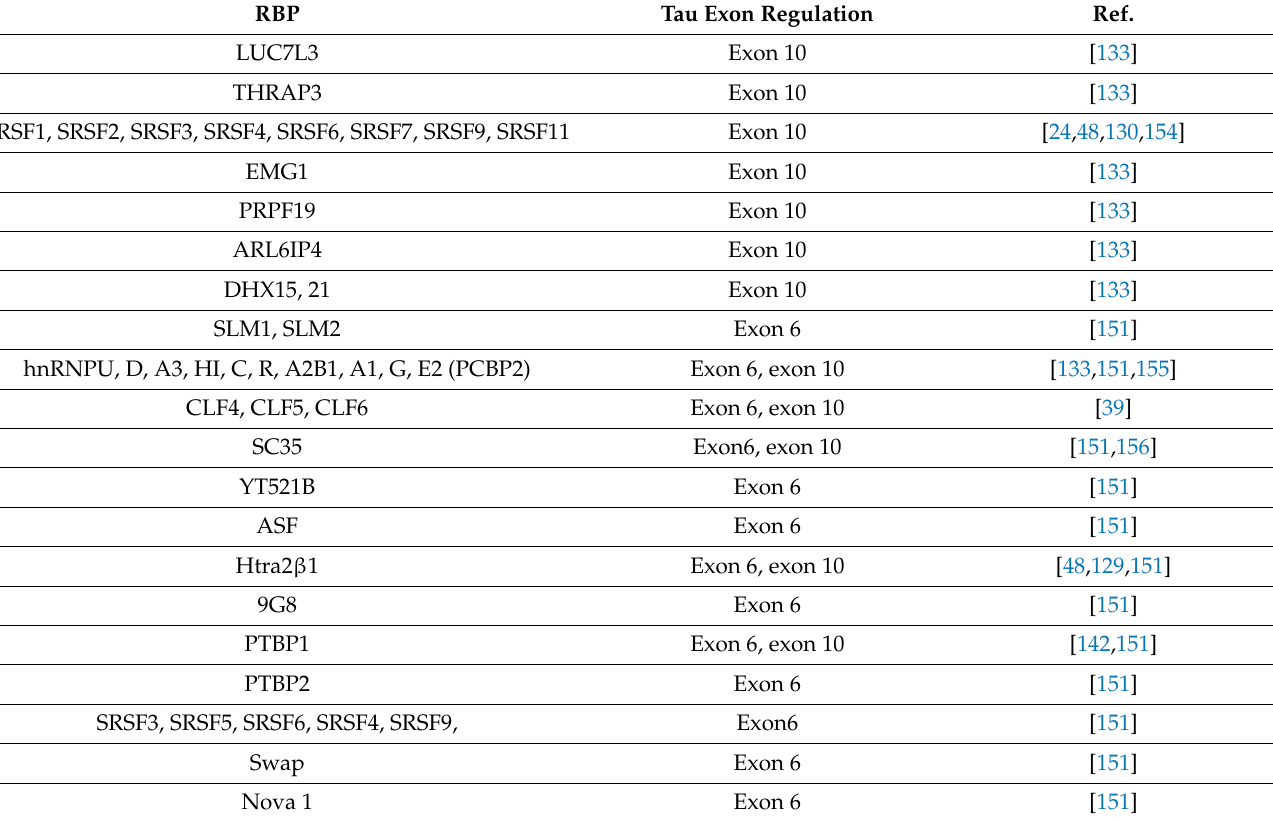
Table 2. RBPs able to influence Tau exons’